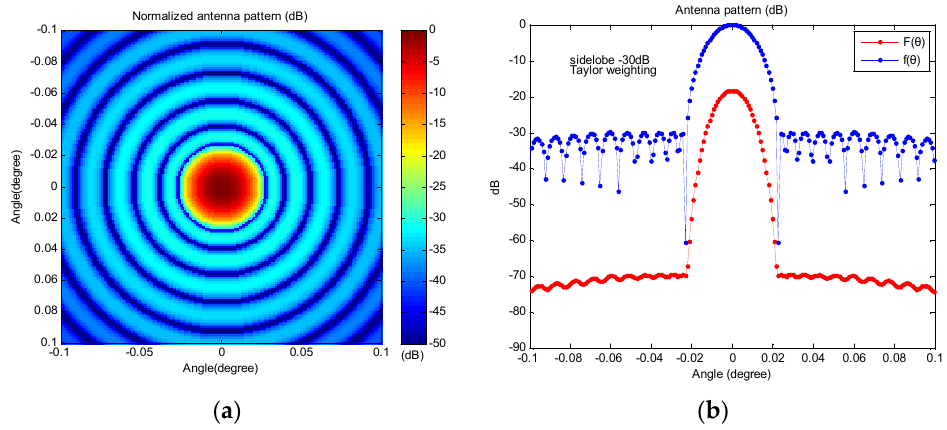
Figure 2. Antenna pattern of a parabolic reflector antenna f ( θ ) with − 30 dB Taylor weighting and its integrated squared antenna pattern F ( θ ) . ( a ) Two dimension antenna pattern along beam direction angles calculated from Equation (11) and Taylor window; ( b ) Antenna pattern and its integrated squared antenna pattern at nadir.